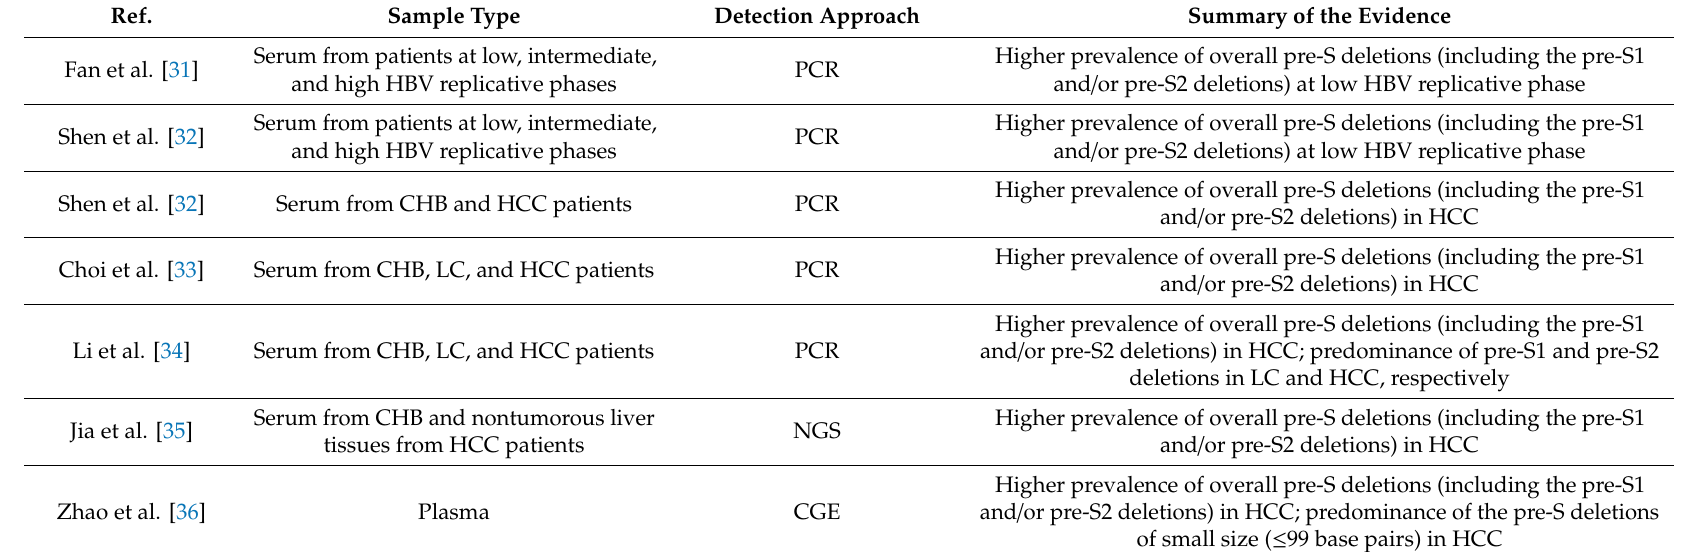
Table 2. The prevalence of pre-S mutants in patients with di ff erent stages of chronic HBV infection and liver diseases.